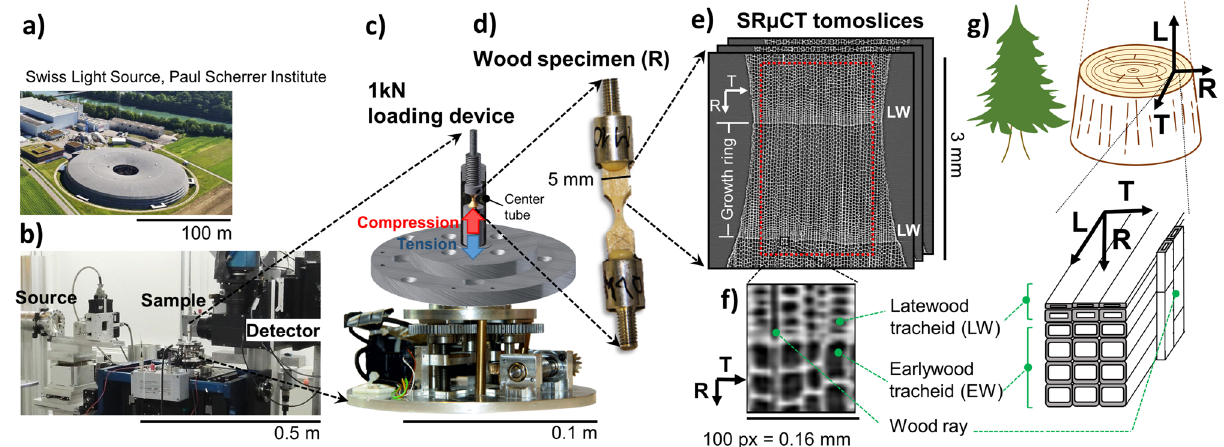
Figure 1. ( a – c ) Setup for Synchrotron Radiation Micro-Computed Tomography (SRμCT) of wood. Experiments were performed ( a ) at Swiss Light Source (SLS) of Paul Scherrer Institute, ( b ) at the Tomograhic Microscopy and Coherent Radiology Experiments (TOMCAT) beamline, ( c ) with an integrated uniaxial loading device. For softwood R-specimen ( d ), typical ( e ) tomoslices are shown, which illustrate the periodic ( f ) latewood (LW) and softwood (EW) layers in radial direction (R). The anatomic model ( g ) shows the tubular symmetry of tracheids along the grain direction (L) and of wood rays along